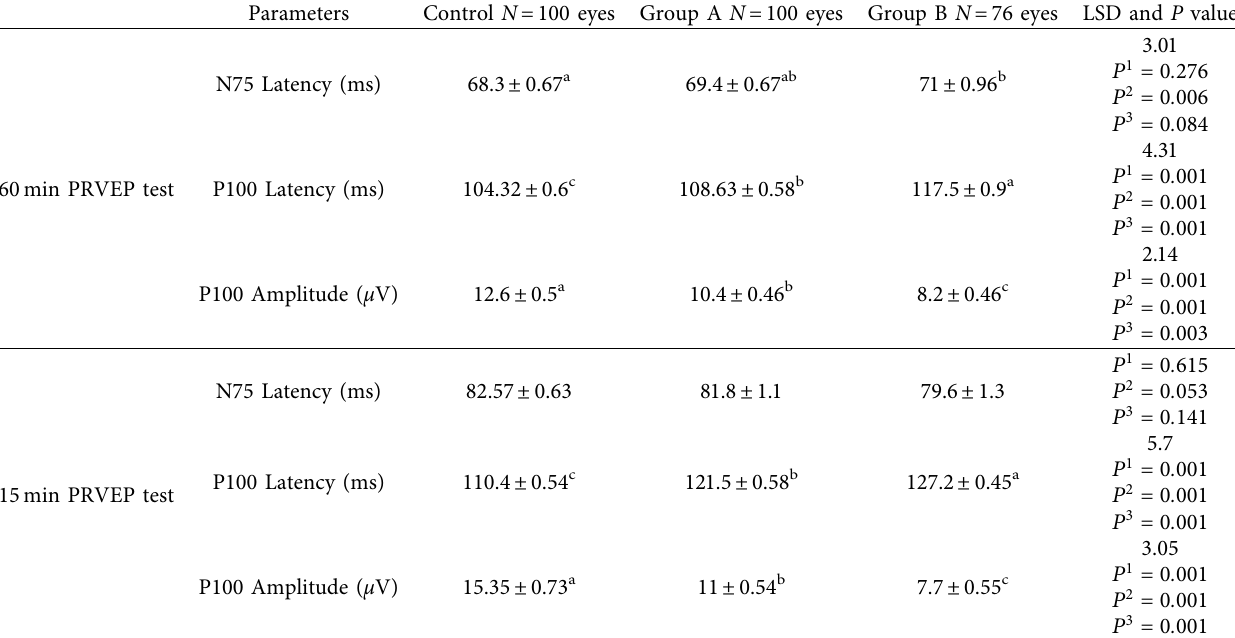
Table 2: The PRVEP tests results of both eyes in each group.